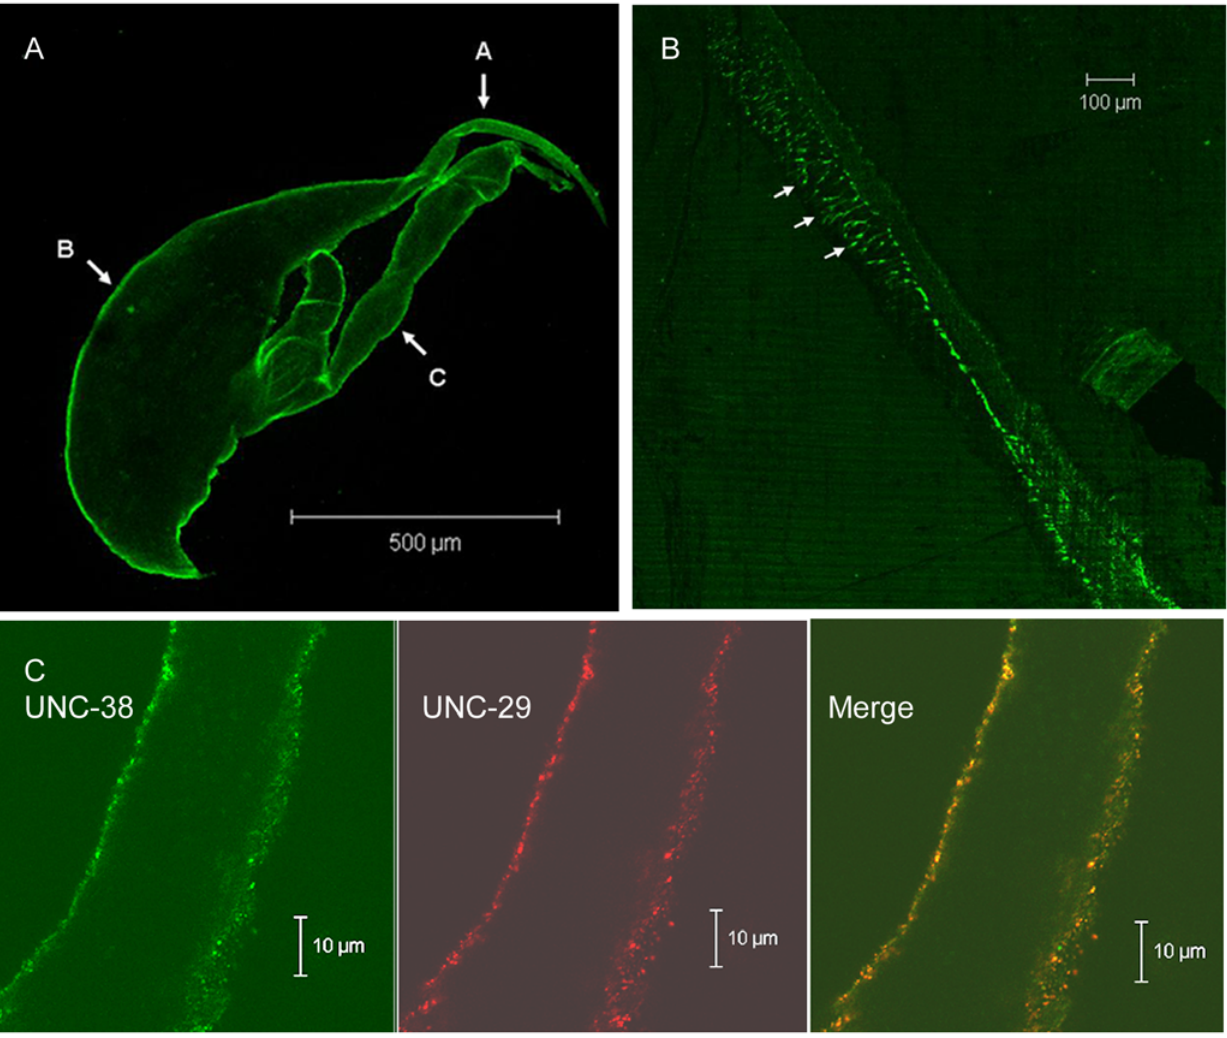
Figure 2. Immunolocalisation of nAChR subunits in isolated A.suum muscle cells. A) Confocal microscope images showing indirect immunofluorescent labelling of Ascaris suum muscle with primary antibody against Asu-UNC-38 and FITC conjugated secondary antibody. A whole muscle cell is shown, with Asu-UNC-38 localised to the cell membrane over the entire cell surface. Arrow A indicates the muscle cell arm, B the bag region of the cell, and C the contractile region. B) Asu-UNC-38 localised to the muscle arms where contact with the nerve cord is made to form the neuromuscular junction (indicated by arrows). No labelling of the nerve cord itself was observed. C) Co-localisation of Asu-UNC-29 and Asu-UNC-38 on the muscle cell arm (region A in panel